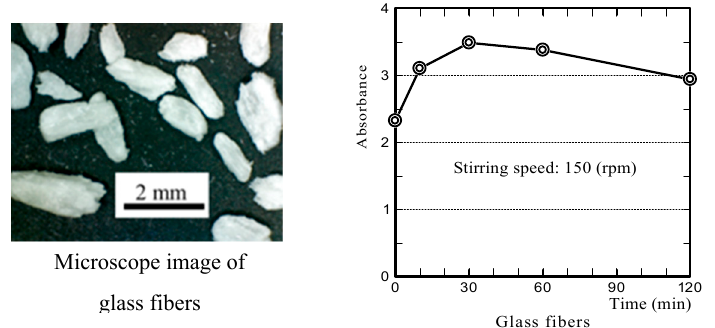
Figure 9. Microscope image of the glass fibers and the changes in absorbance for the MB solution.